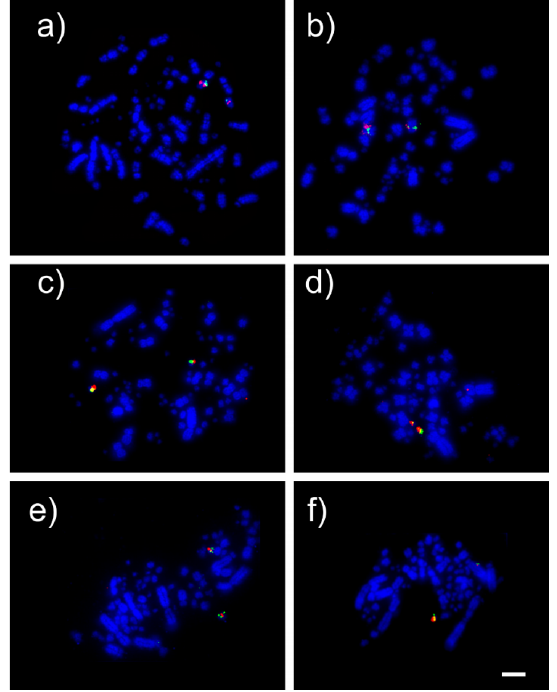
Figure 2. Examples of FISH experiments using chicken (GGA) bacterial artificial chromosome (BAC) probes in shorebirds. FISH results in C. canutus : chromosome 12 CH261 ‐ 60P3 (red) and CH261 ‐ 4M5 (green) ( a ) and chromosome 14 CH261 ‐ 122H14 (red) and CH261 ‐ 69D20 (green) ( b ). FISH results in J. jacana : chromosome 18 CH261 ‐ 72B18 (red) and CH261 ‐ 60N6 (green) ( c ) and chromosome 26 CH261 ‐ 170L23 (red) and CH261 ‐ 186M13 (green) ( d ). FISH results in V. chilensis : chromosome 17 CH261 ‐ 42P16 (ged) and TGMCBA ‐ 375I5 (green) (e) and chromosome 28 CH261 ‐ 72A10 (red) and CH261 ‐ 64A15 (green) ( f ). Scale bar 5 μ m. Table 2. Microchromosome correspondence between chicken and three shorebirds: Vanellus chilensis (VCH), Jacana jacana (JJA), and Calidris canutus (CCA).